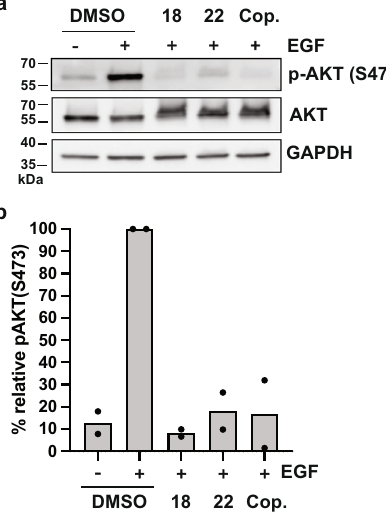
stimulatedDMSOcontrol. N =2fromtwoindependentexperiments. c CellTiter-Glo assay to monitor the viability of cells after 72h of exposure to increasing con- centrations of 18 , 22 , or copanlisib in a medium supplemented with FBS. A non- linear fi t of inhibitor versus normalized response is shown. Means (dots) and SD (error bars) of N =4 (copanlisib) or N =7 (compounds 18 or 22 ) measurements combined from two independent experiments are shown.